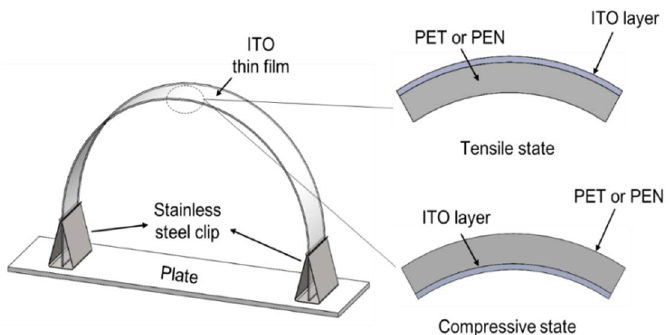
Figure 1. Schematic diagram of static bending test setup and cross section of sample structure of indium tin oxide (ITO) thin film.